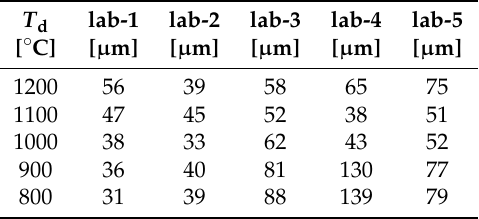
Figure 3. The micrographs show the prior austenite grain boundaries of lab-4 after deformation at 900 ◦ C, 1000 ◦ C and 1100 ◦ C, revealed by picric etching. The direction of deformation is indicated by the red arrows. Table 2. Overview of the p γ -GS of the investigated alloys and heat